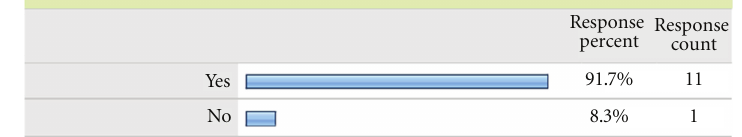
Figure 2: Survey Excerpt: The influence of the course on students’ intention in taking more biology courses.